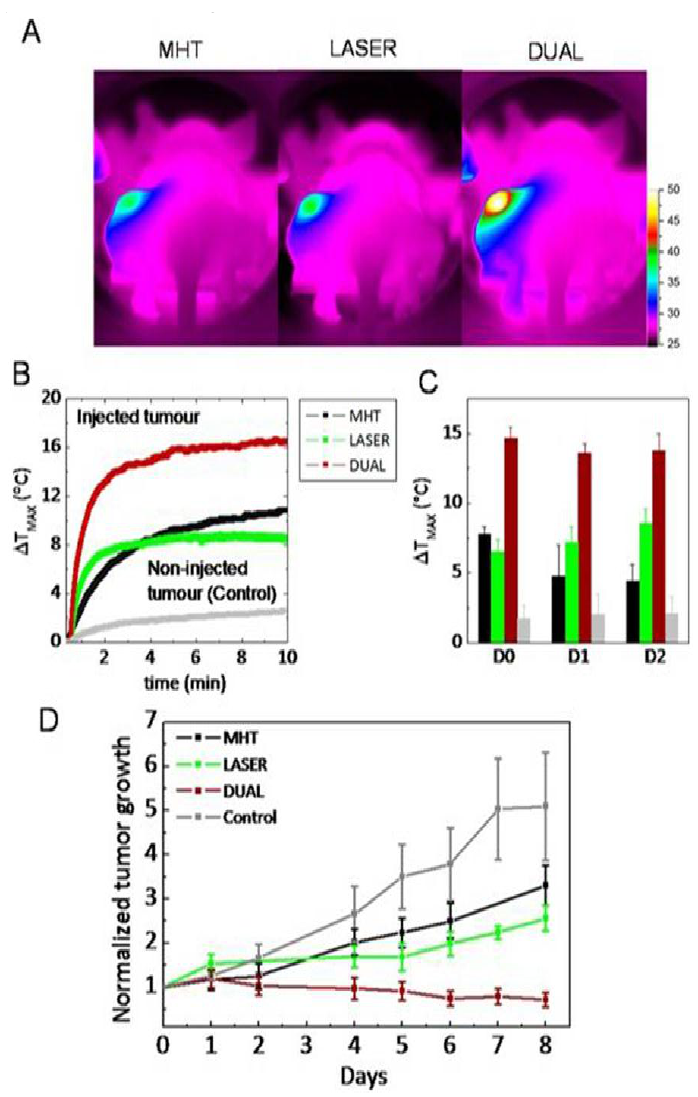
Figure 4. ( A ) Thermal images acquired after the intratumoral injection of nanocubes and the application of magnetic hyperthermia (MHT), near-infrared (NIR)-laser irradiation, or dual-mode treatment (both effects); ( B ) thermal elevation curves for the non-injected tumor in the dual condition; ( C ) average final temperature increase obtained on day 0 (1h after injection) and one and two days after injection for non-injected tumors; and ( D ) average tumor growth in nanocube-injected mice. Reproduced with permission from [143]. Copyright American Chemical Society, 2015.